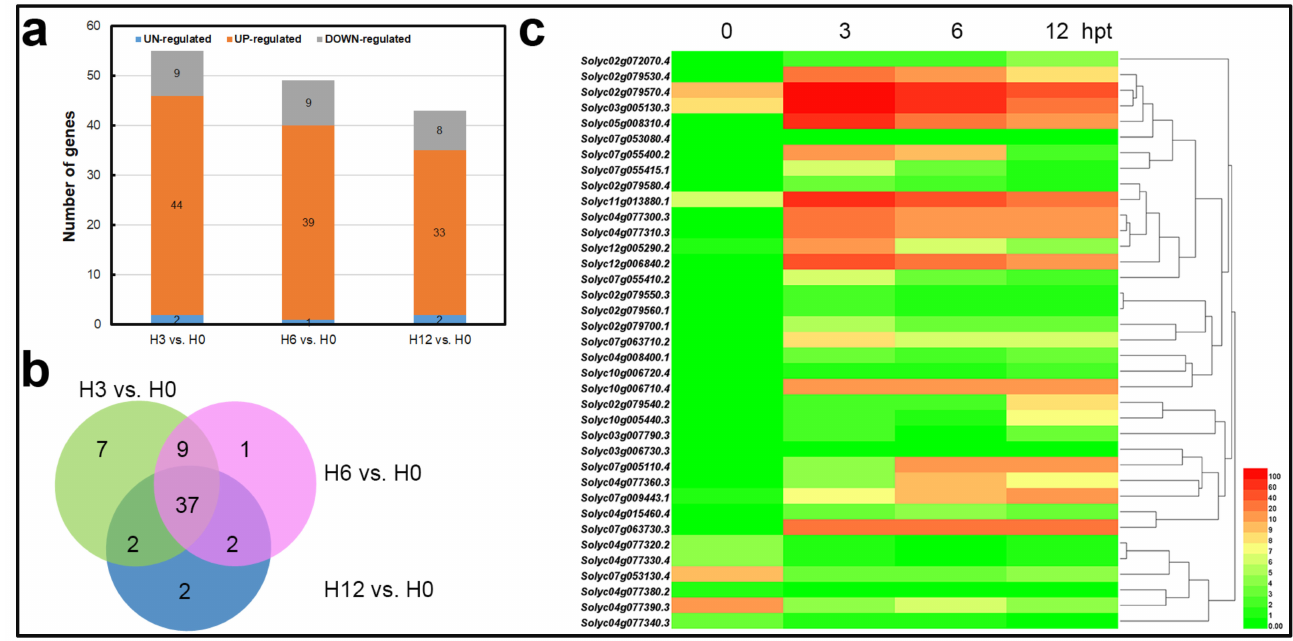
Figure 6. Expression profiles of G-LecRK genes responding to SCR96 treatment. ( a ) The bar graph represents the numbers of G-LecRK genes that were up-, down-, or unregulated by SCR96 in the three comparison sets (H3 vs. H0, H6 vs. H0, H12 vs. H0). ( b ) Venn diagram showing the overlap between the three comparison sets. ( c ) Heat map and dendrograms of hierarchical clustering showing the expression patterns of all 37 G-LecRK DEGs at 0, 3, 6, and 12 hpt in response to